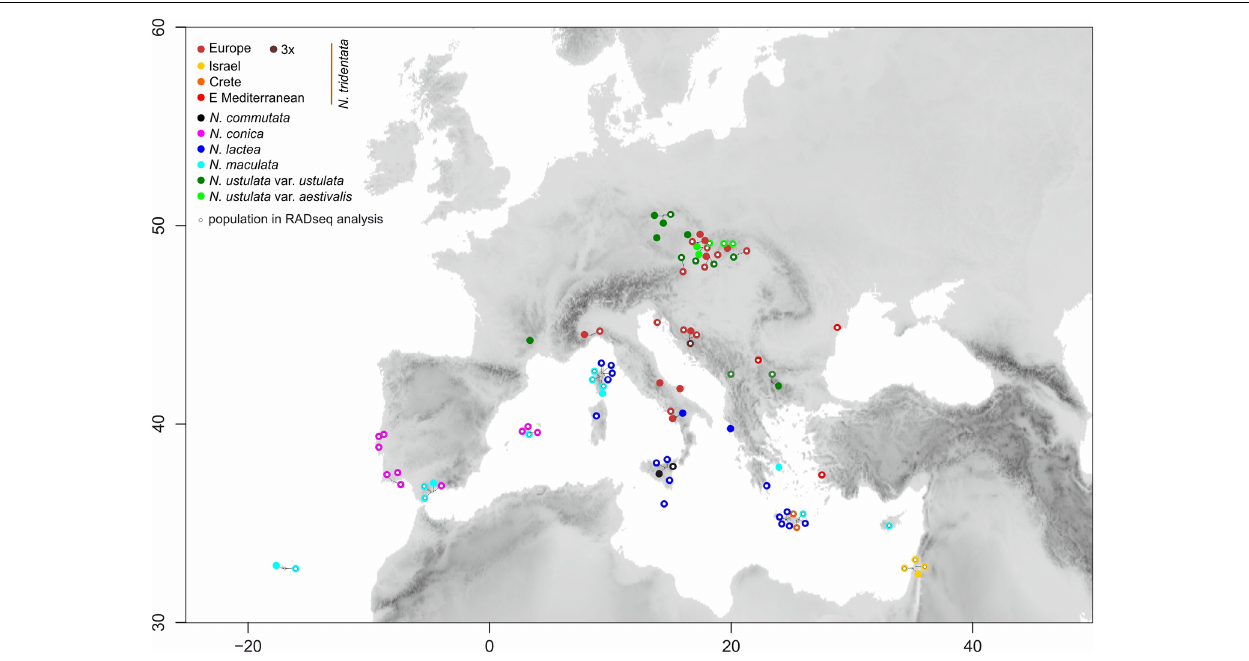
FIGURE 1 | Map showing the locations of the ninety populations of Neotinea species included in the study. The color of filled circles corresponds to recognizable taxa/morphotypes. Smaller open circles within color ones indicate populations used in RADseq